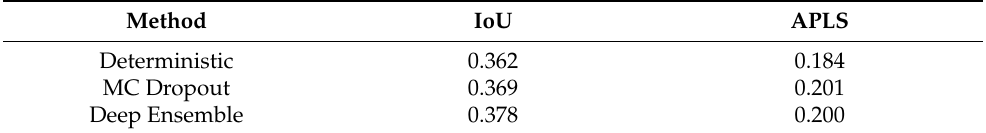
Table 1. Best model results on test data, selected from multiple training runs. Each score is the average over all image chips in the test set. MCD matches DEs on APLS, but DEs perform best